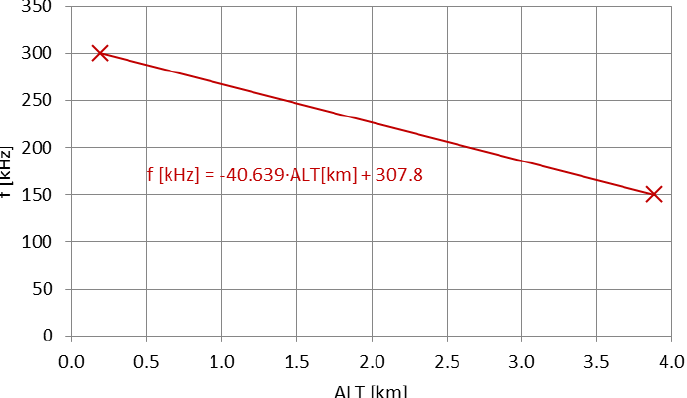
Figure 16. The apparent frequency decrease prediction function plotted for the LF/270 kHz case from [54]. The formula is based on the maximum obtainable signal coverage from the HML elevated antenna in reference to the ground-based antenna from RKS Topolná (the main transmitting site on 270 kHz [62]).